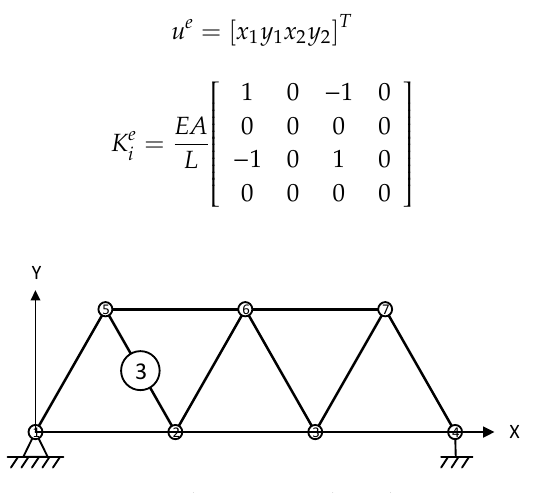
Figure 1. Grid structure with 11 elements.